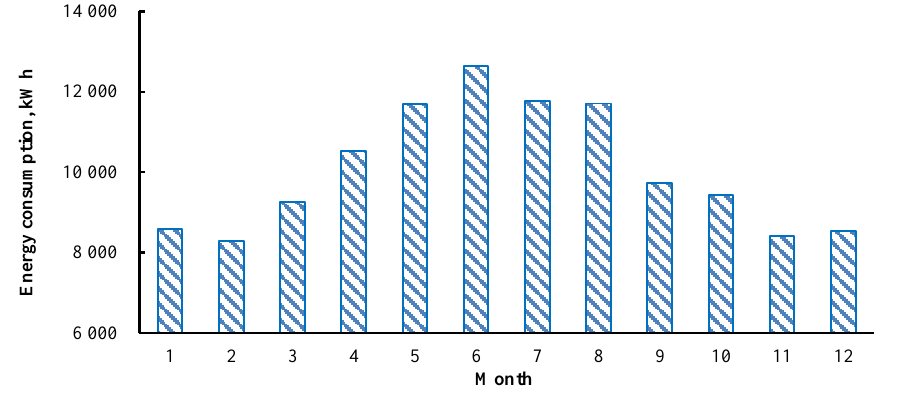
Fig. 5. The electricity load of the entire community in each month.